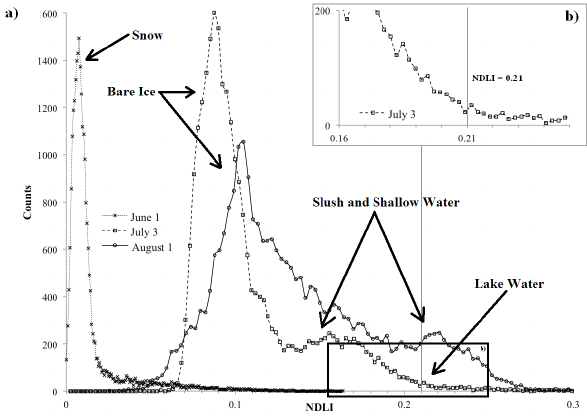
Figure 2. (a) NDLI histograms for select MODIS scenes from 2011. Dates chosen are 2 Fig. 2. (a) NDLI histograms for select MODIS scenes from 2011. Dates chosen are representative of pre-lake filling, mid-season peak representative of pre-lake filling, mid season peak coverage, and late season, respectively 3 coverage, and late season, respectively (see Fig. 4). Vertical grey (see Figure 4). Vertical grey lines indicate identification threshold in (a) and in the mid 4 lines indicate identification threshold in (a) and in the mid-season season zoom-in (b) . 5 close-up (b)